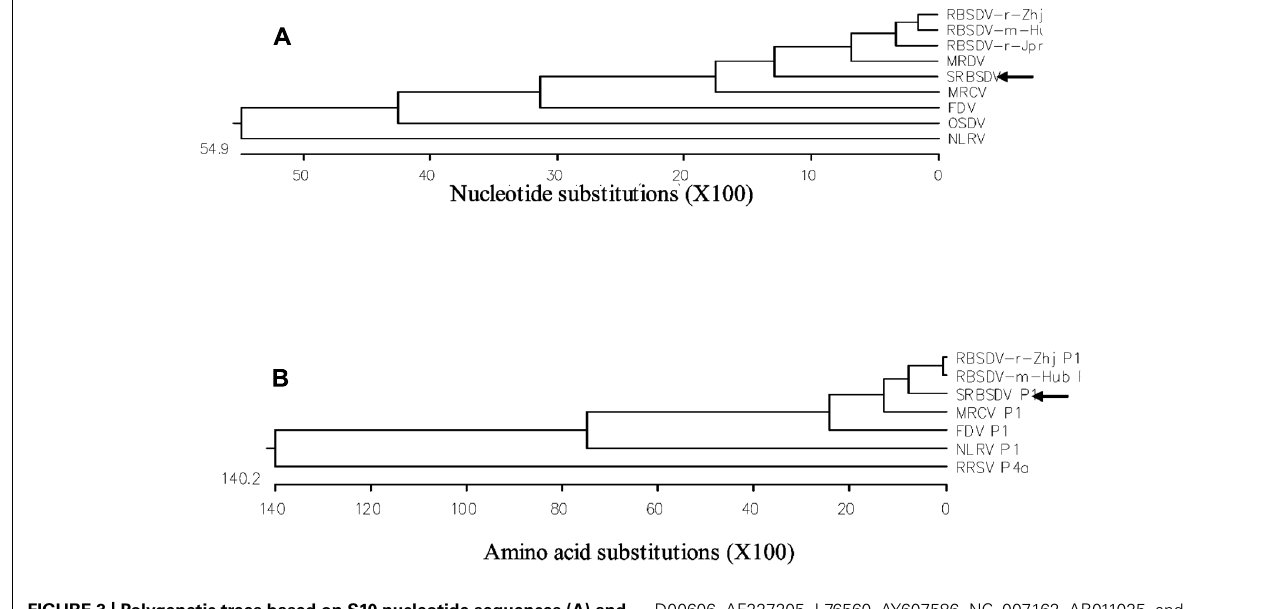
FIGURE 3 | Polygenetic trees based on S10 nucleotide sequences (A) and P1 amino acid sequences (B) of SRBSDV and other related fijiviruses. From Zhou etal. (2008) andWang etal. (2010a).To construct the phylogenetic trees, viral nucleotide and amino acid sequences were obtained from GenBank, aligned using MegAlign, and analyzed using the neighbor-joining method (http://www.ncbi.nlm.nih.gov). S10 nucleotide sequence accession numbers are EU523360,